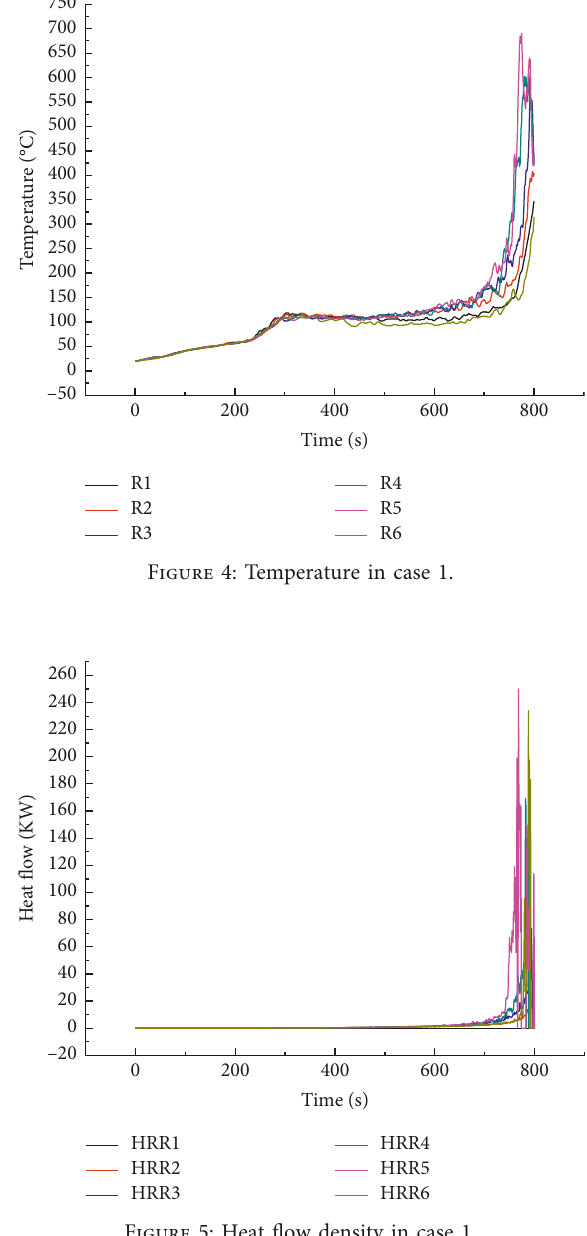
Figure 5: Heat flow density in case 1.